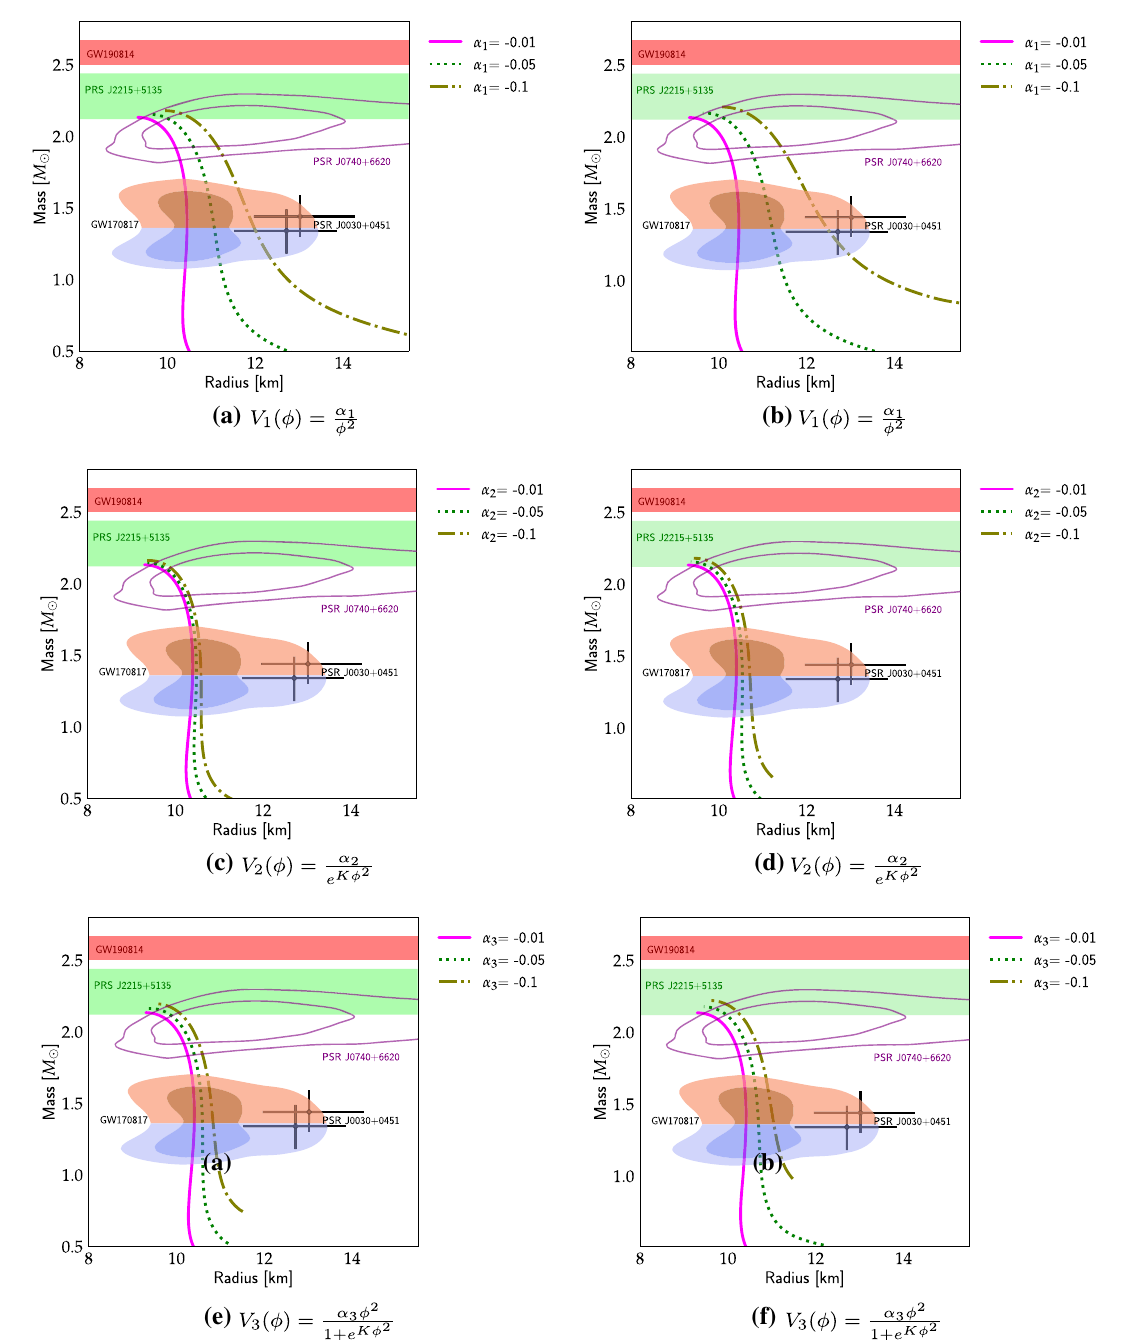
Fig. 5 The mass–radius relation of neutron stars in mimetic gravity for WFF1 EoS. φ( 0 ) = 1: left panels and φ( 0 ) = 0 . 8: right panels and K = 0 .